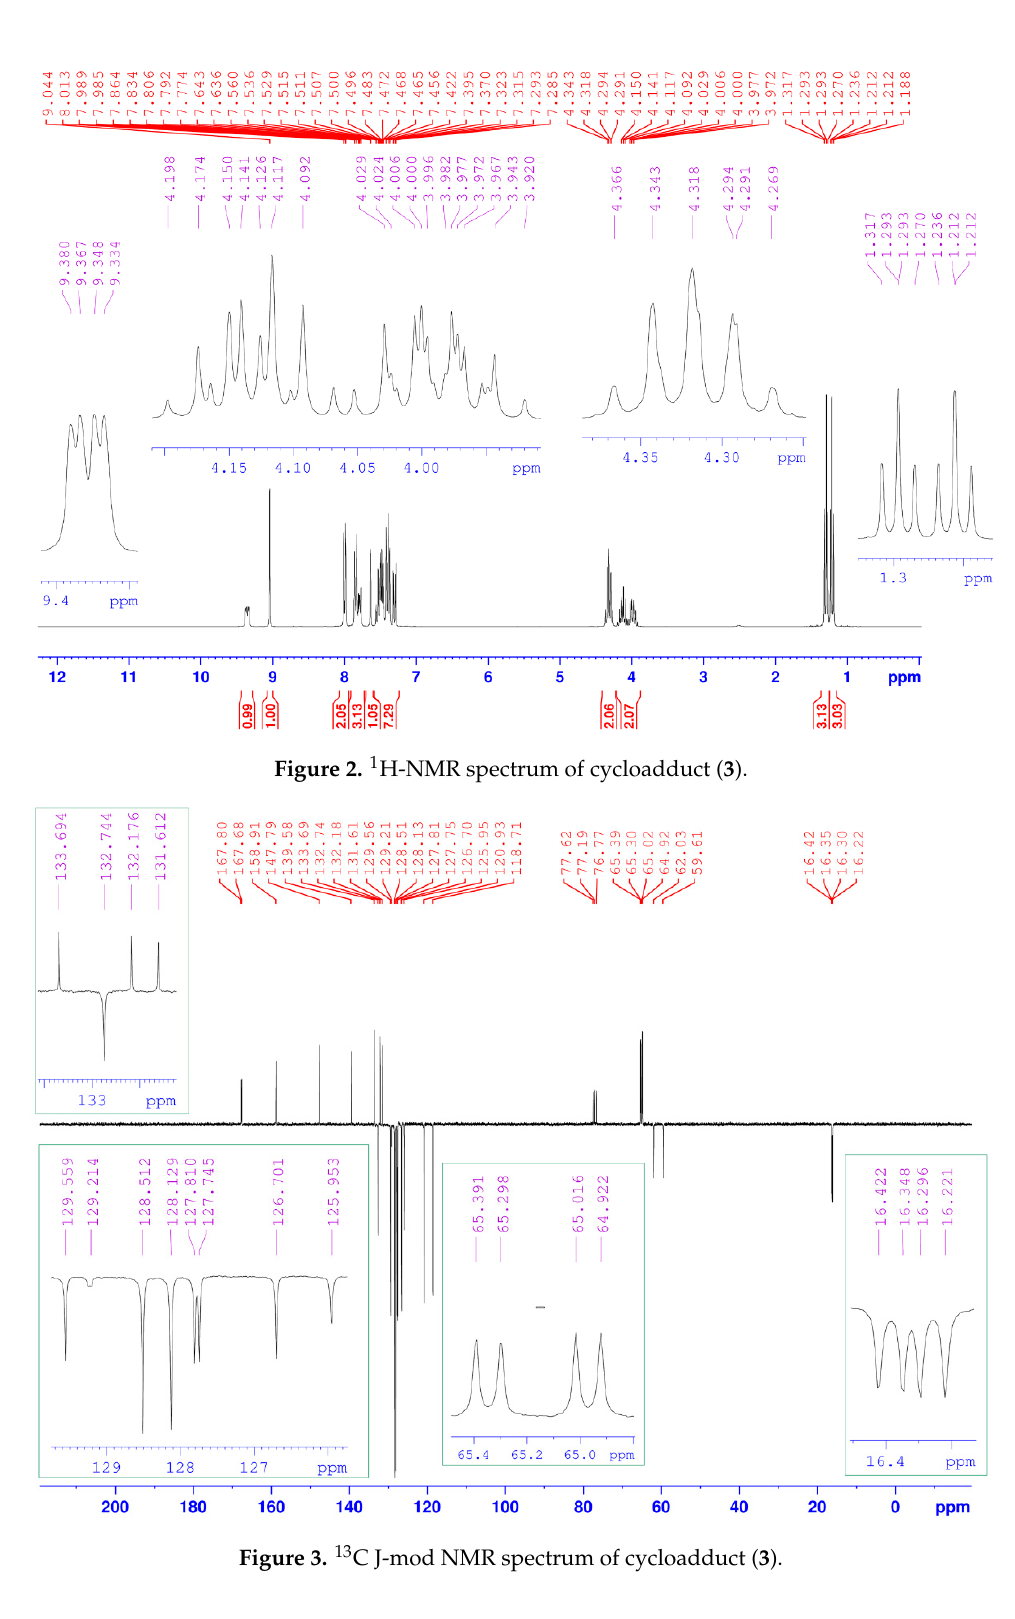
Figure 3. 13 C J-mod NMR spectrum of cycloadduct ( 3 ).